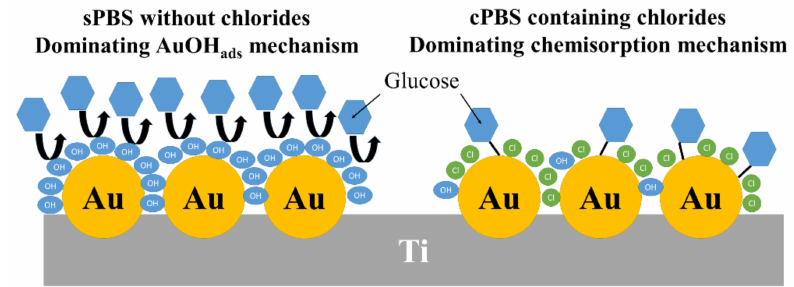
Figure 8. Schematic illustration of the e ff ect of chloride ions contained in cPBS on the mechanism of glucose